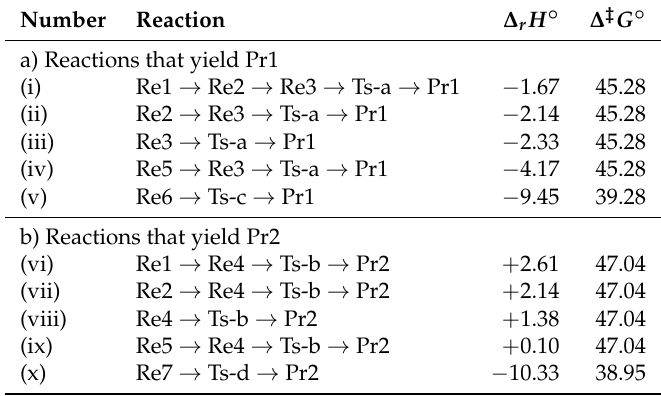
Figure 6. The ELDs for four possible TSs: (a) TS-a, (b) TS-b, (c) TS-c, and (d) TS-d, and their related initial (is) and final states (fs). The code of the reactants and the products follows Table 7. The relative energy of each TS corresponds to the energy barrier, whereas the relative energy of the fs corresponds to the reaction energy. Table 8. The standard enthalpy of reaction ( ∆ r H ◦ ) and the standard Gibbs energy of activation ( ∆ ‡ G ◦ ) at 298.15 K (in kcal/mol): For Re5, only the shortest pathway is